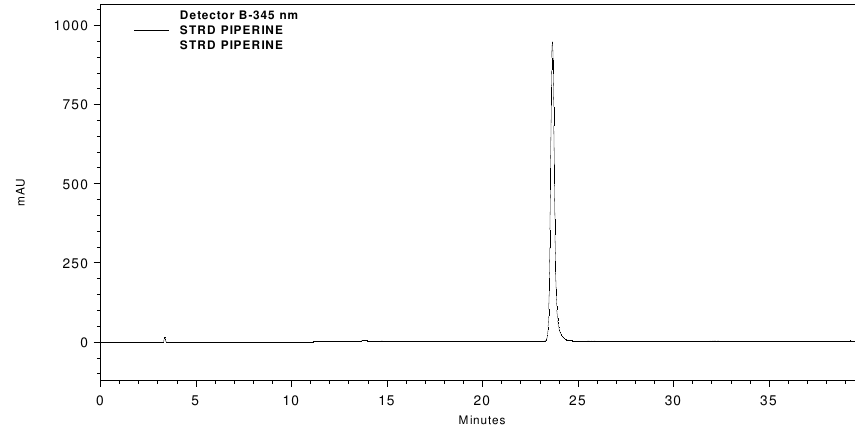
Figure 1 . HPLC chromatogram of standard piperine